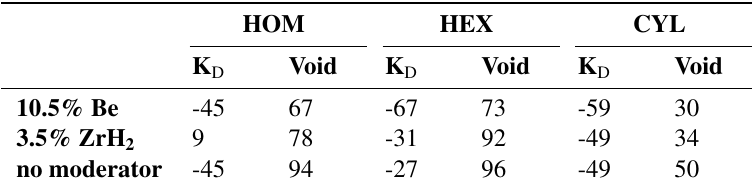
Table 2: Bias on Doppler constant and void coeff. in pcm for A3-T4 scheme (33 groups in T4) compared to T4 reference